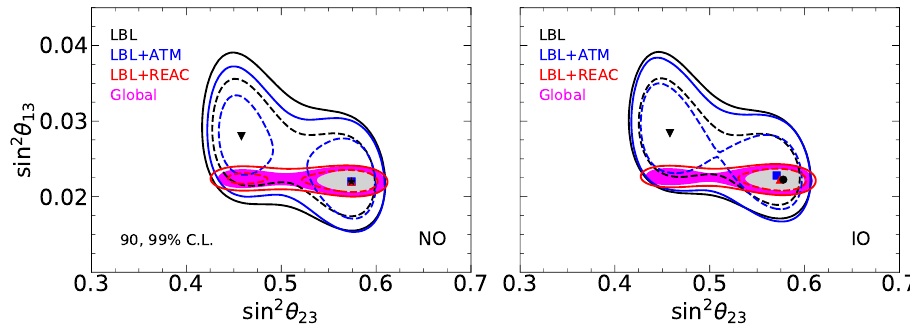
Figure 7 . Allowed regions in the sin 2 θ 23 – sin 2 θ 13 plane from several combinations of data sets: LBL (black lines), LBL+ATM (blue), LBL+REAC (red) and global analysis (colored regions). The down-triangle, square and up-triangle correspond to the best fit values obtained from the combination of data sub-sets, while the black star (left panel) and black dot (right panel) denote the best value obtained from the global fit, for normal and inverted ordering,